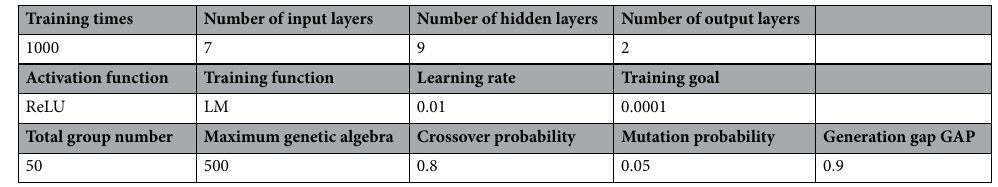
Table 4. Algorithm parameter